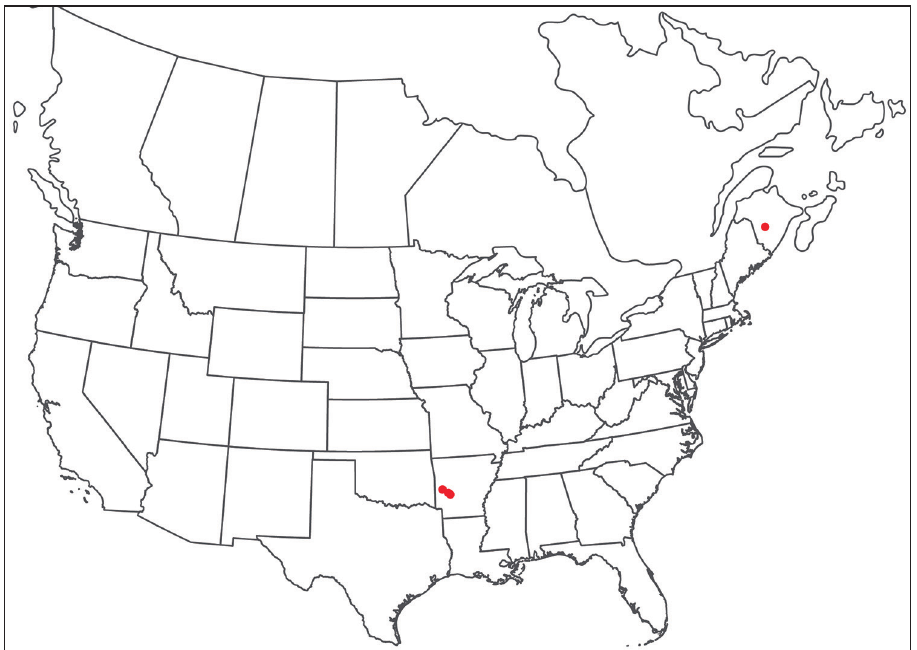
Figure 264. Torrenticola unimaculata sp. n.